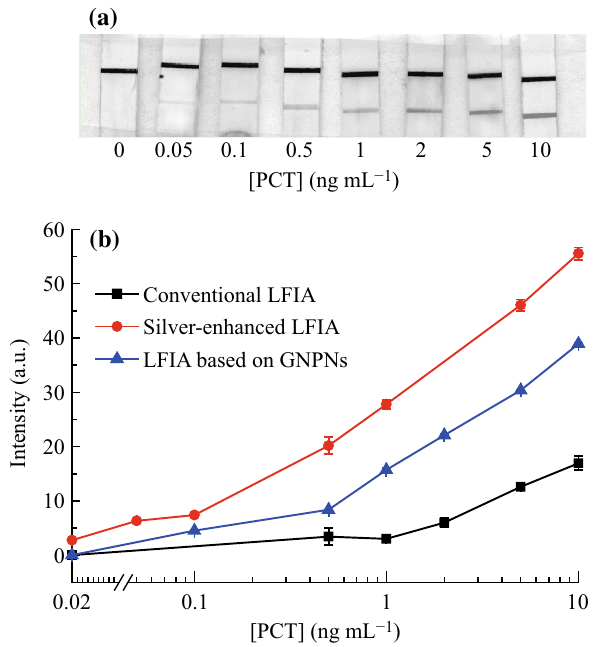
Fig. 6 a Silver-enhanced LFIA for the detection of PCT. b Calibra- tion curves for PCT obtained from LFIA based on 20 nm GNSs, GNPNs, and silver-enhanced